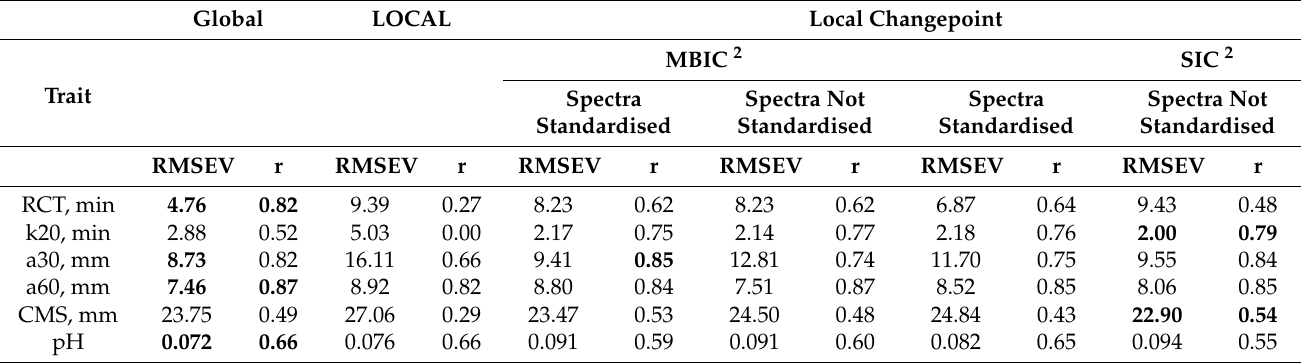
Table 4. Root mean square error of validation samples (RMSEV) and correlation (r) between the true and predicted trait values for the observations with the 5% greatest Mahalanobis distance from the centre of the principal component space using global, LOCAL, and local changepoint approaches 1 .